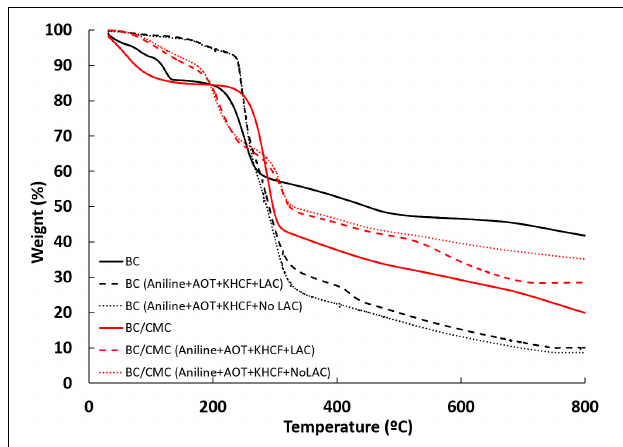
FIGURE 5 | TGA analysis of BC and BC/CMC materials functionalized with polyaniline under different